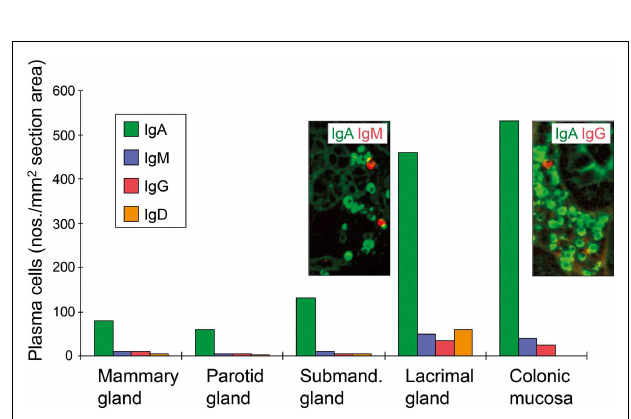
FIGURE 7 |Average tissue densities of plasmablasts/plasma cells producing different Ig classes at various normal secretory tissue sites as indicated . Representative areas illustrating merge of immunofluorescence staining (see color key) are shown for submandibular gland and colonic lamina propria. Based on published data from the author’s